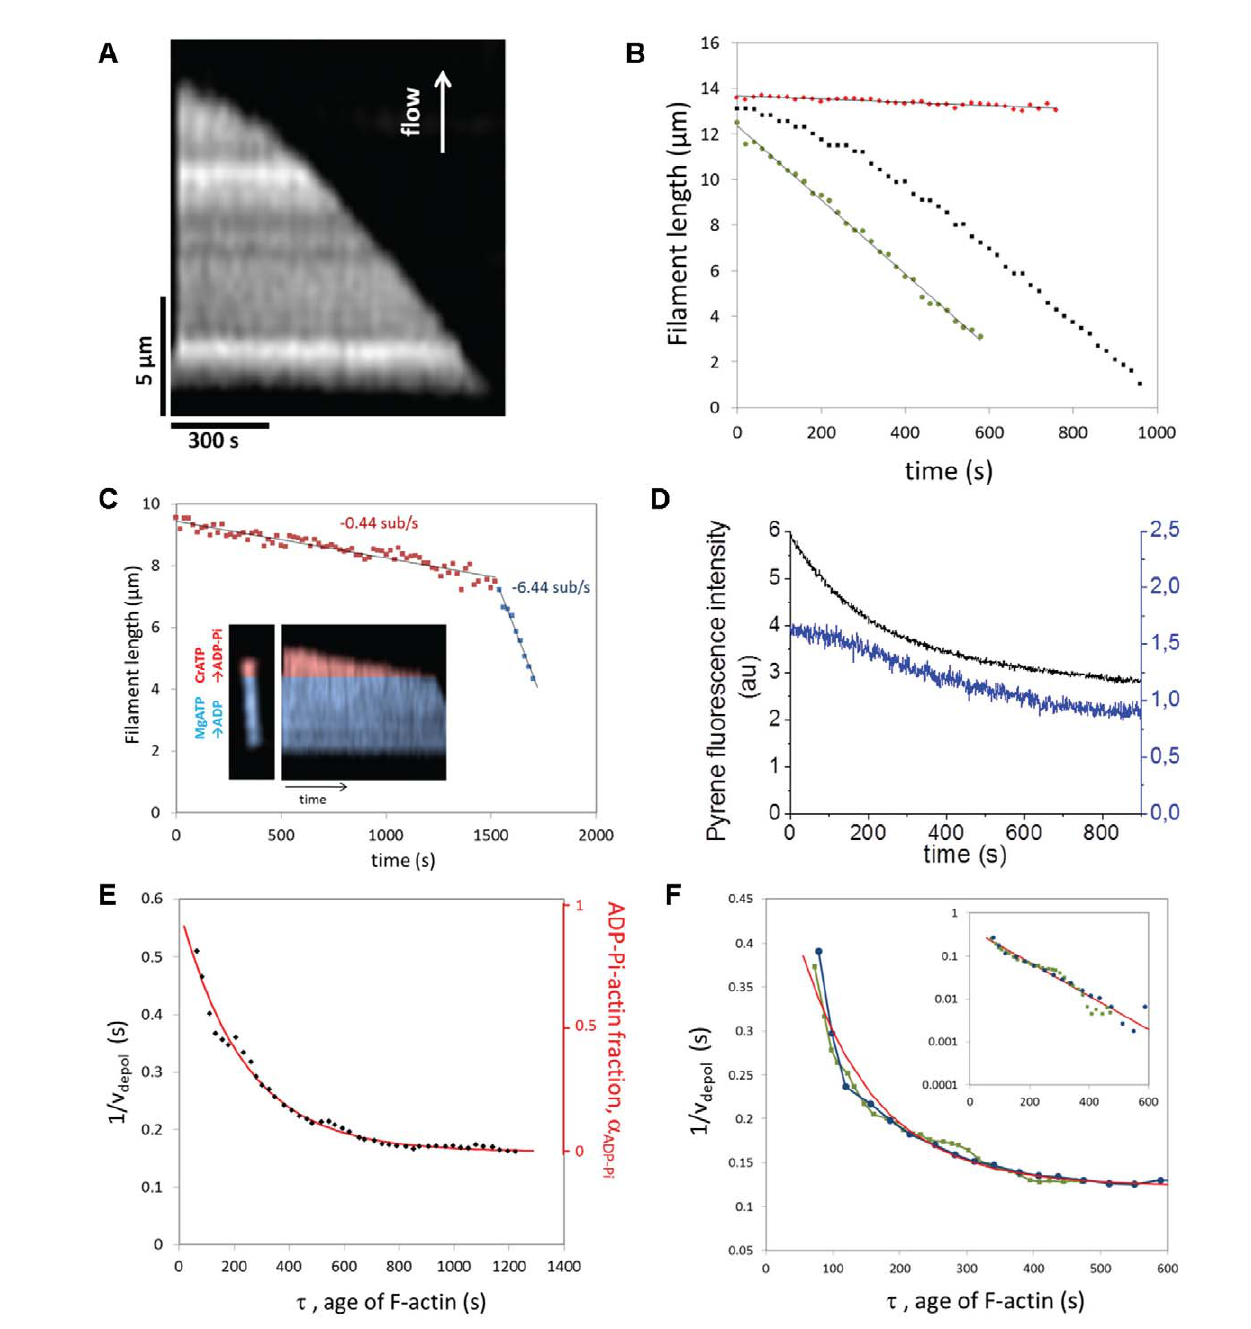
Figure 2. Depolymerization of actin filaments and measurement of their ADP-Pi content. (A) Kymograph of a depolymerizing actin filament, after elongation with 1.5 m M MgATP-actin for 5 min. (B) Depolymerization of the MgATP-actin filament from (A) (black), of an ADP-actin filament (green) and of a CrATP-actin filament (red). (C) Depolymerization of a filament constructed with an artificial strict ADP-Pi cap, mimicking vectorial Pi release. Inset: fluorescence image of the filament, showing the ADP-Pi and ADP regions in pseudo colors, and kymograph of its depolymerization. (D) Bulk solution depolymerization assays. Filaments are grown from 0.25 nM spectrin-actin seeds at 2 m M actin (50% pyrene labeled) and depolymerized by 6-fold dilution with 5 m M Latrunculin A, at times at which 20% (blue curve, right y -axis) or 75% (black curve, left y -axis) of actin has polymerized. Under these conditions, the barbed ends generated by spontaneous nucleation are negligible. (E) 1/ v depol versus the age of F-actin for the filament shown in (A) and (B). This curve is fitted by an exponential (red line) with rate constant k r =0.0043 s 2 1 , directly representing Pi decay in the filament. (F) Pi decay profiles for filaments elongated with 2 m M actin during 2.5 (green) or 10 min (blue), compared with an exponential ! 1 1 { fit (red line). Inset: log-linear plot of for the same data. v depol v ADP depol